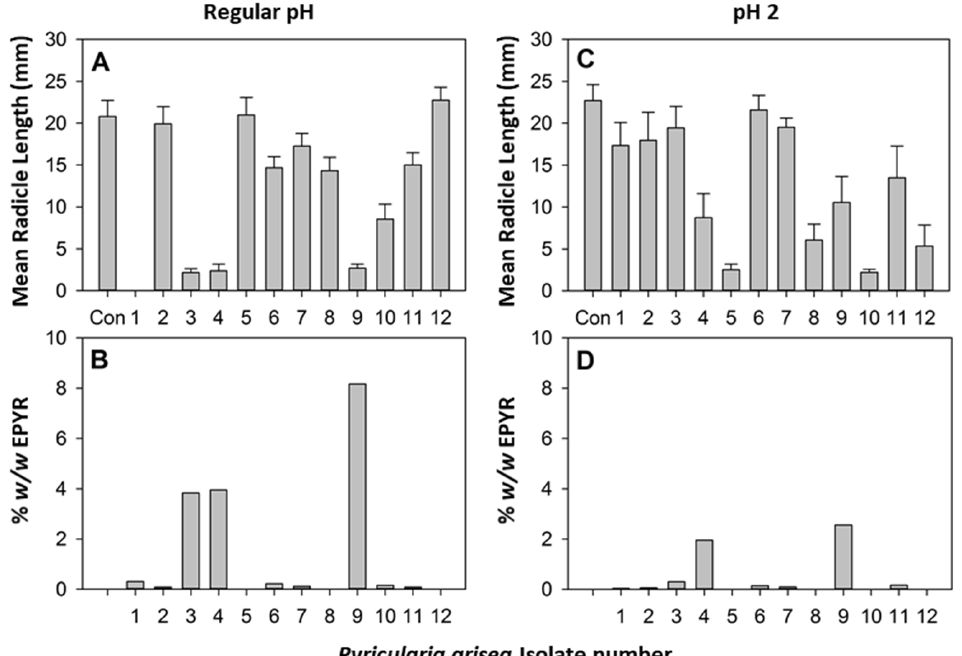
Figure 3. Effect of Pyricularia grisea organic extraction at regular pH from culture filtrates of the twelve P. grisea isolates (1–12) on ( A ) 3-day radicle length in a buffelgrass seedling bioassay and ( B ) EPYR concentrations in those 12 extracts. ( C , D ) Parallel results from organic extraction at pH 2. Error bars represent standard error of the mean.